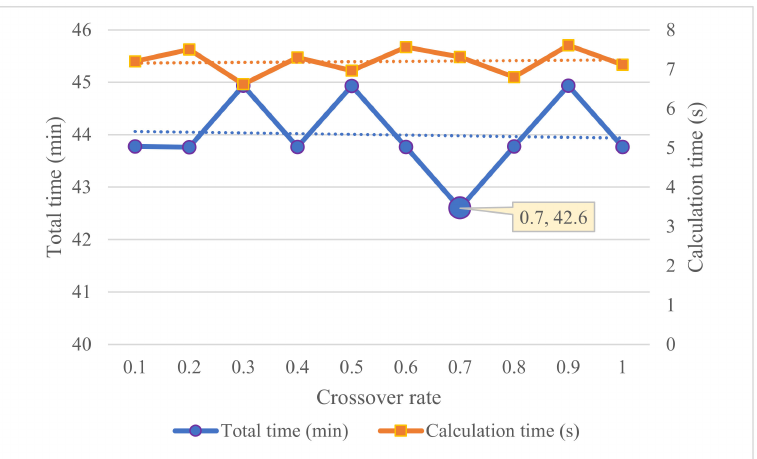
Figure 12. Influence of crossover rate on GA.